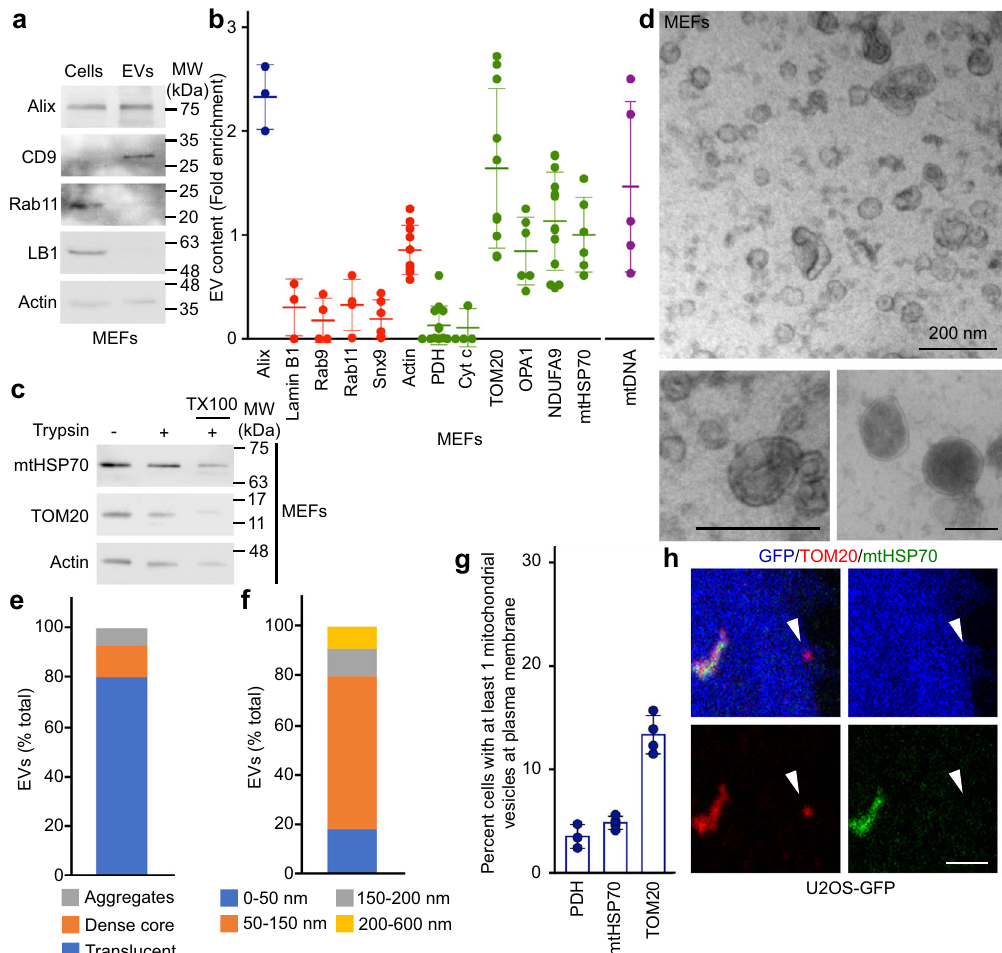
Fig. 2 Selective inclusion of mitochondrial proteins in EVs. a EV markers were analysed by western blot in 20 µ g cell extracts and 5 µ g MEFs EVs isolated as in Fig. 1. b Quanti fi cation of protein inclusion in MEF EVs. The amount of the indicated protein present in EVs was normalised to its cellular content. Individual points represent independent experiments. Bars show the average ± SD. Alix, Exosome marker (blue); Lamin B1, nuclear protein; Rab9, Rab11, Snx9, endosomal proteins; Cyt c, IMS protein, OPA1, IM protein. Mitochondrial proteins (green), non-mitochondrial proteins (red), mtDNA (purple). c MEF EVs isolated as above were treated with Trypsin in the absence or the presence of detergent (TX100) and analysed by western blot for the presence of the indicated proteins. d – f MEF EV ultrastructure was analysed by EM and quanti fi ed based on structure ( e ) and size ( f ). Representative images are shown